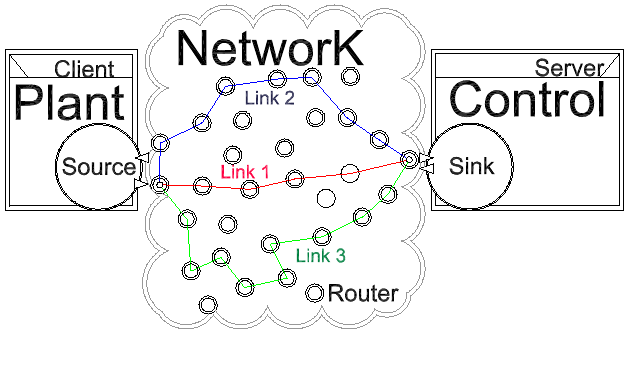
Figure 1. Cliente-Server for